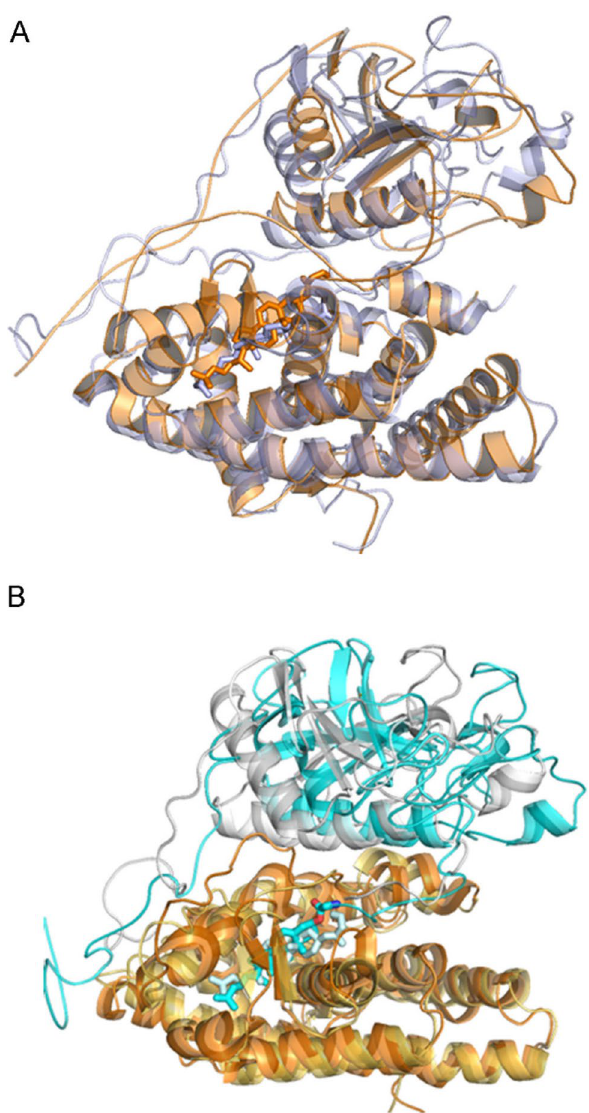
Figure 4. Molecular modelling of the ARwt–SHH-N–cholesterol complexes. ( A ) Overlay of the ARwt– SHH-N–cholesterol structures: docked (gray) and at the end of 100 ns of MD simulation (orange). ( B ) Orientation of the cholesterol SHH-N molecule in the AR–SHH-N–cholesterol complexes at the end of 100 ns of MD simulation: in the complex with the wild type, ARwt (cyan) and in the complex with its T878A mutant (light blue). Alignment was performed on AR. Cholesterol molecules in the aligned complexes are represented as